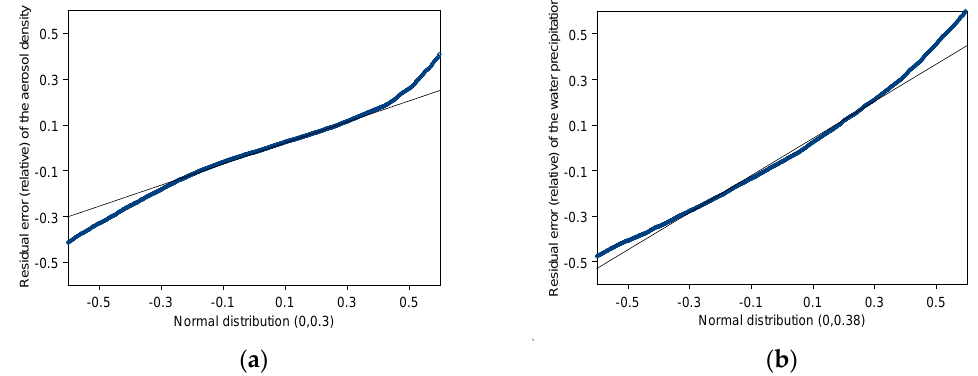
Figure 10. Quantile–quantile plot that examines the values of two distributions: ( a ) Aerosol density;